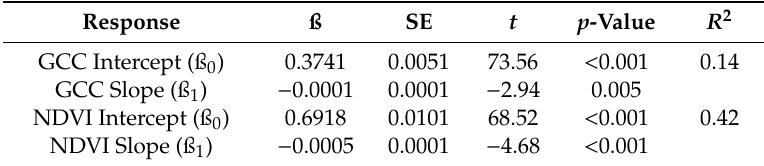
Table 7. Linear regression analyses of distance from unburned forest edge versus mean GCC or mean NDVI values using a 10-m bu ff er radius. Two statistical models were fit, one for GCC and one for NDVI. For each model, we report the response variable, estimates of the coe ffi cients (ß) for the y-intercept and slope, standard error (SE), the test statistic value ( t ), p -value and adjusted R 2 . These models and raw data are visualized in Figure